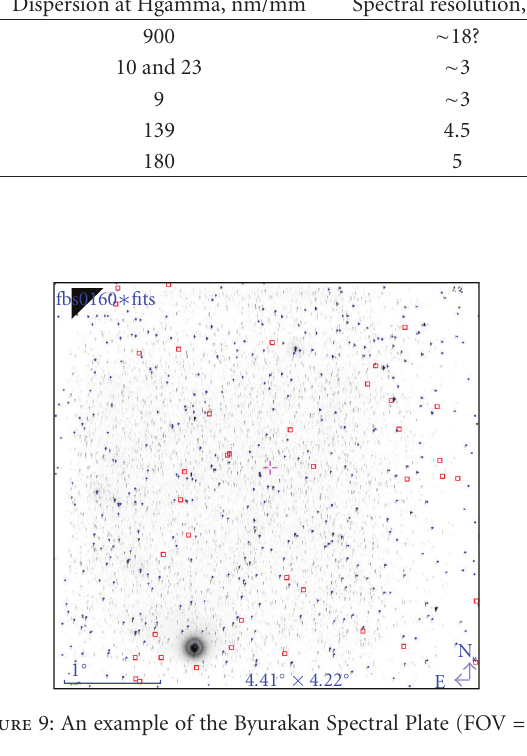
Table 1: Comparison of the parameters of Gaia BR and RP and of selected plate low dispersion spectra. Wavelength range, nm